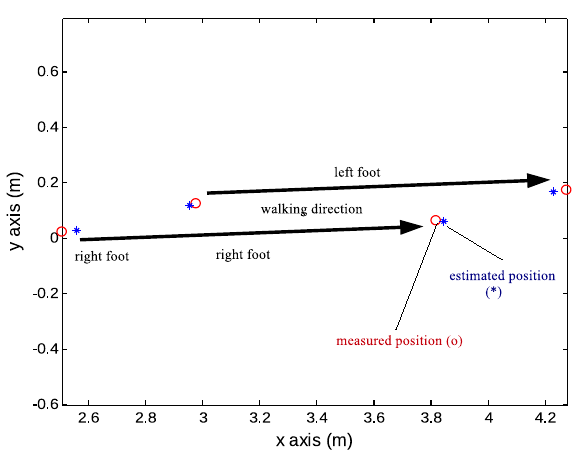
Figure 11. One walking step estimation